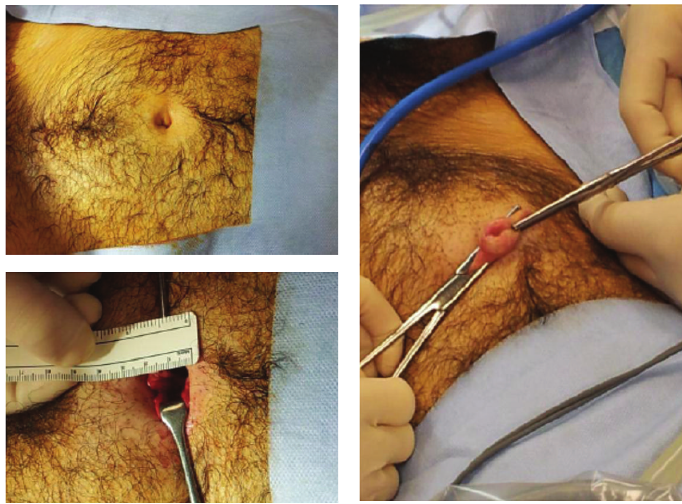
Figure 1: Single-site umbilical incision.